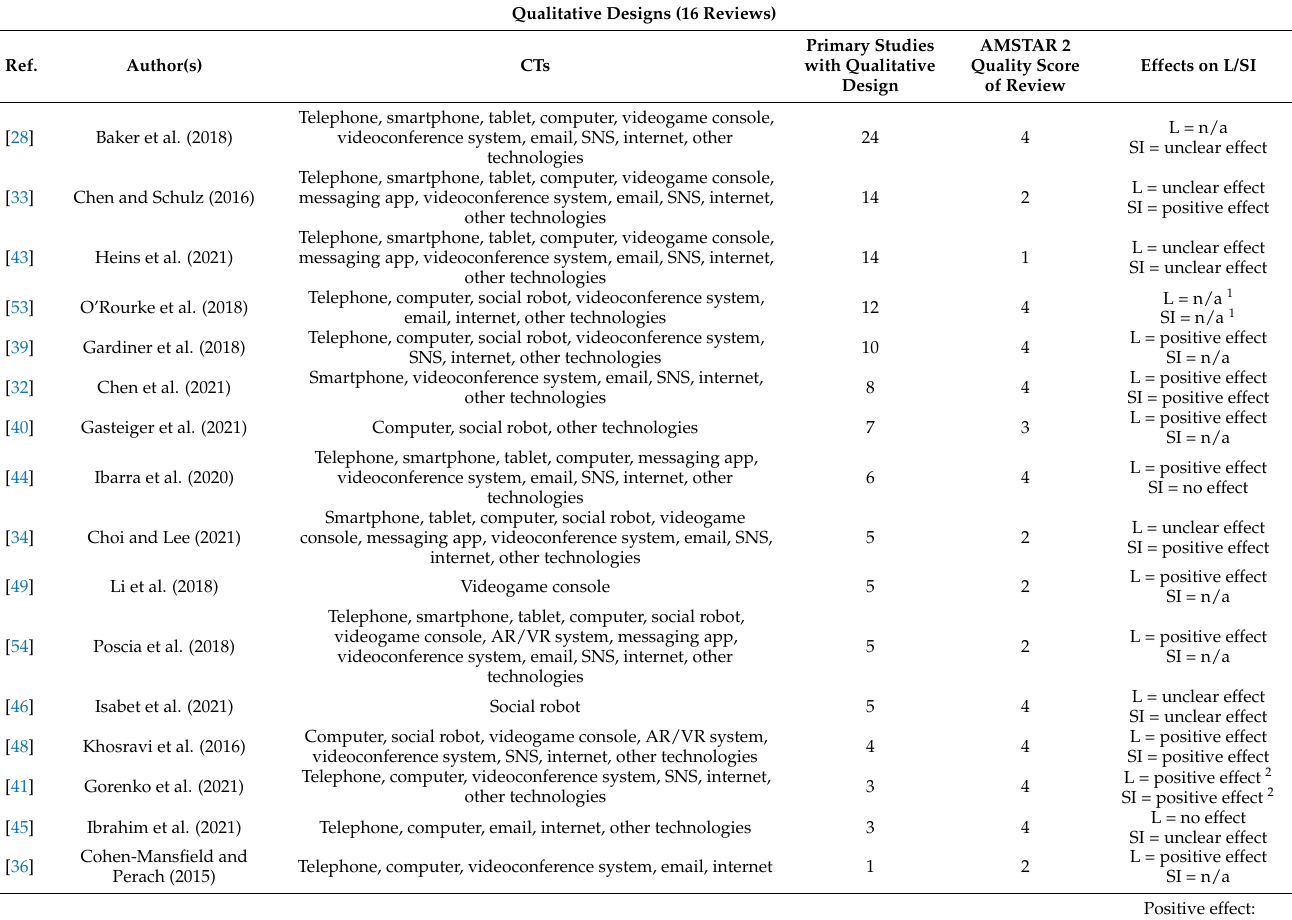
Table 4. Study Designs and Reported Effects of the Use of CTs on Loneliness and Social Isolation Among Older Adults as Represented in the Included Research